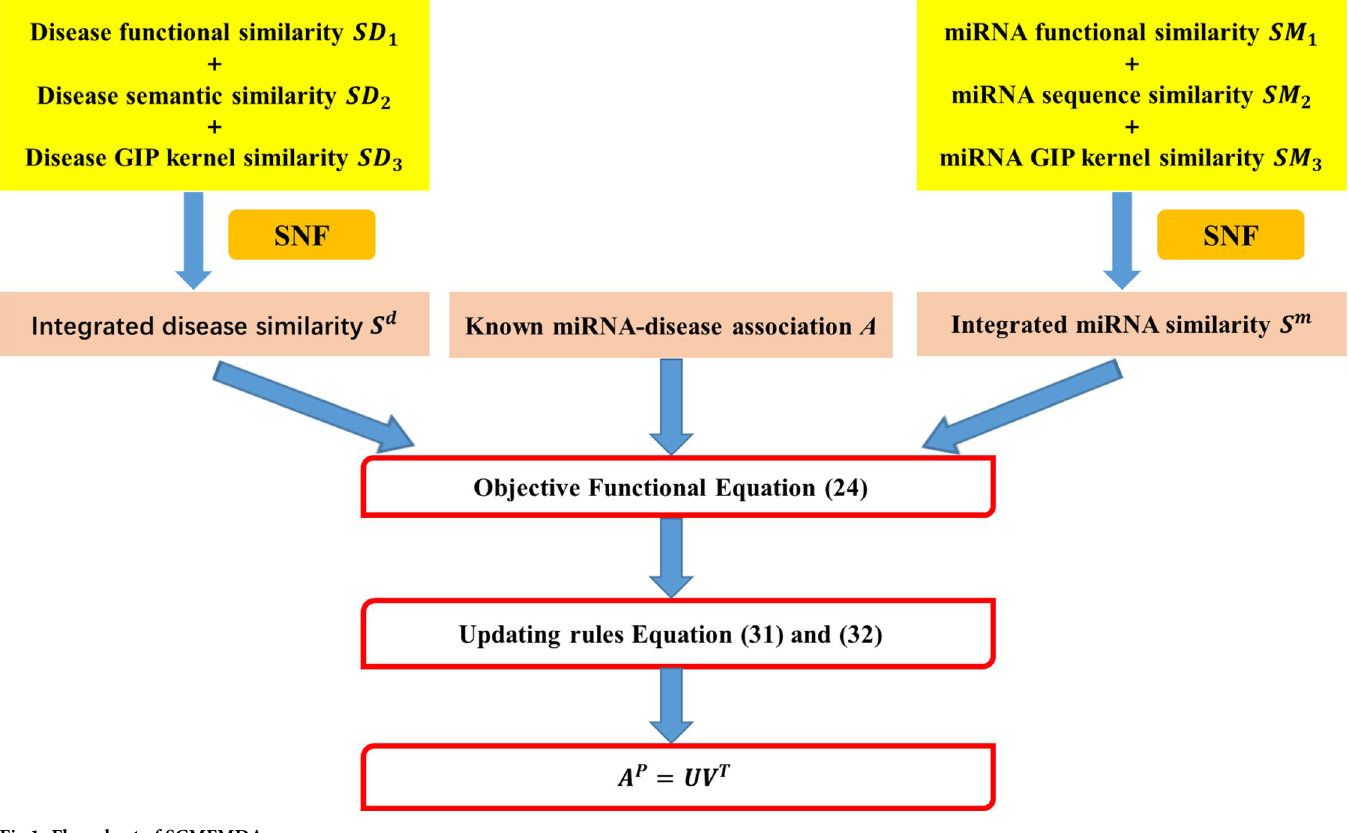
Fig 1. Flow chart of SCMFMDA.